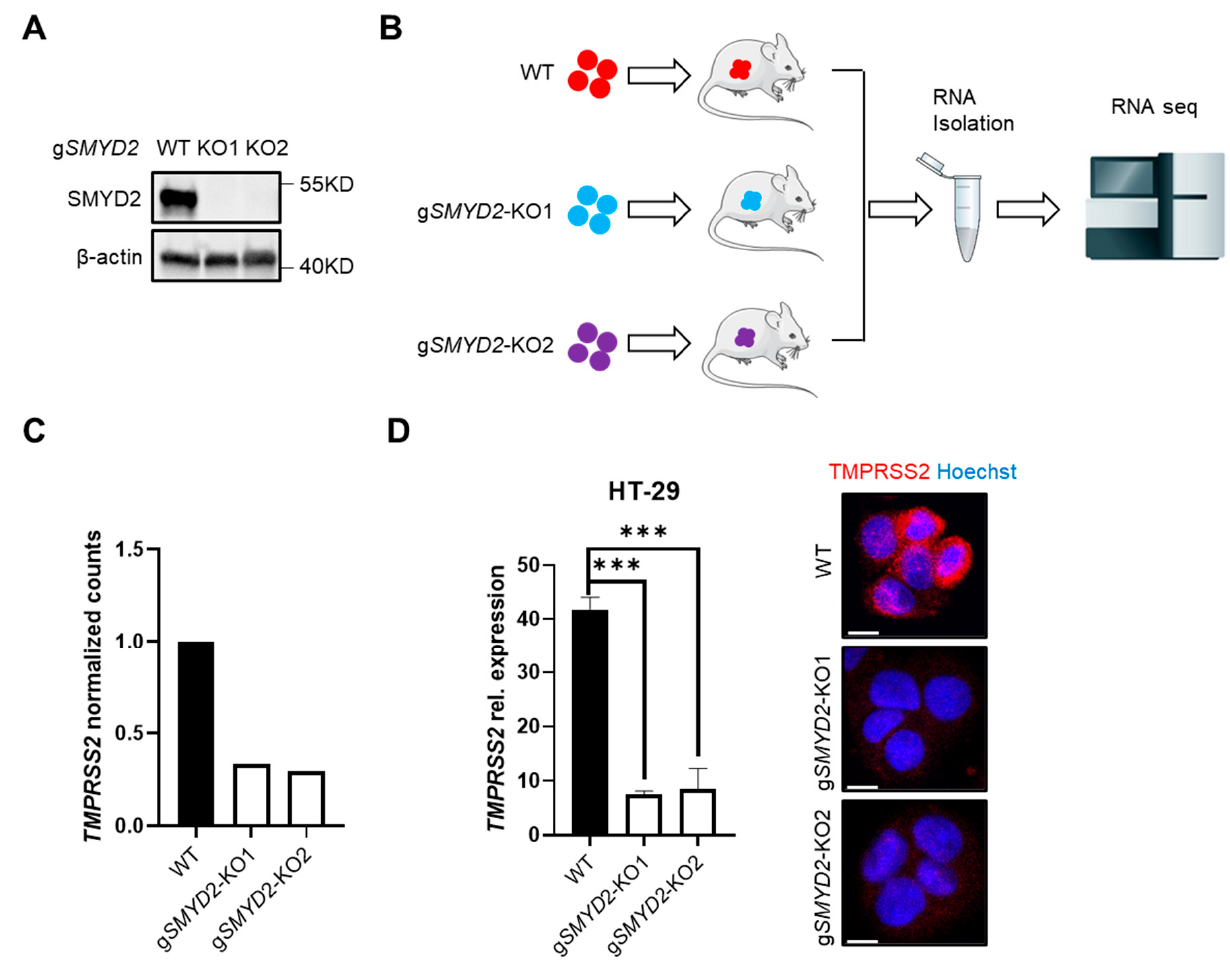
Figure 1. SMYD2 deficiency decreases TMPRSS2 expression in HT-29 cells. ( A ) Immunoblot analysis of SMYD2 in lysates of WT and two clones of CRISPR/Cas9-directed SMYD2 knockout HT-29 cells. β -actin served as a loading control. ( B ) The workflow of RNA-seq analysis on HT-29 xenografts. ( C ) RNA-seq analysis of TMPRSS2 expression (normalized counts) in HT-29 xenografts. ( D ) qPCR analysis ( Left panel ) or immunofluorescence staining ( Right panel) of TMPRSS2 in cultured WT and SMYD2 knockout HT-29 cells. Experiments were performed twice and representative data are shown. *** p < 0.001. Scale bar, 10 µm.